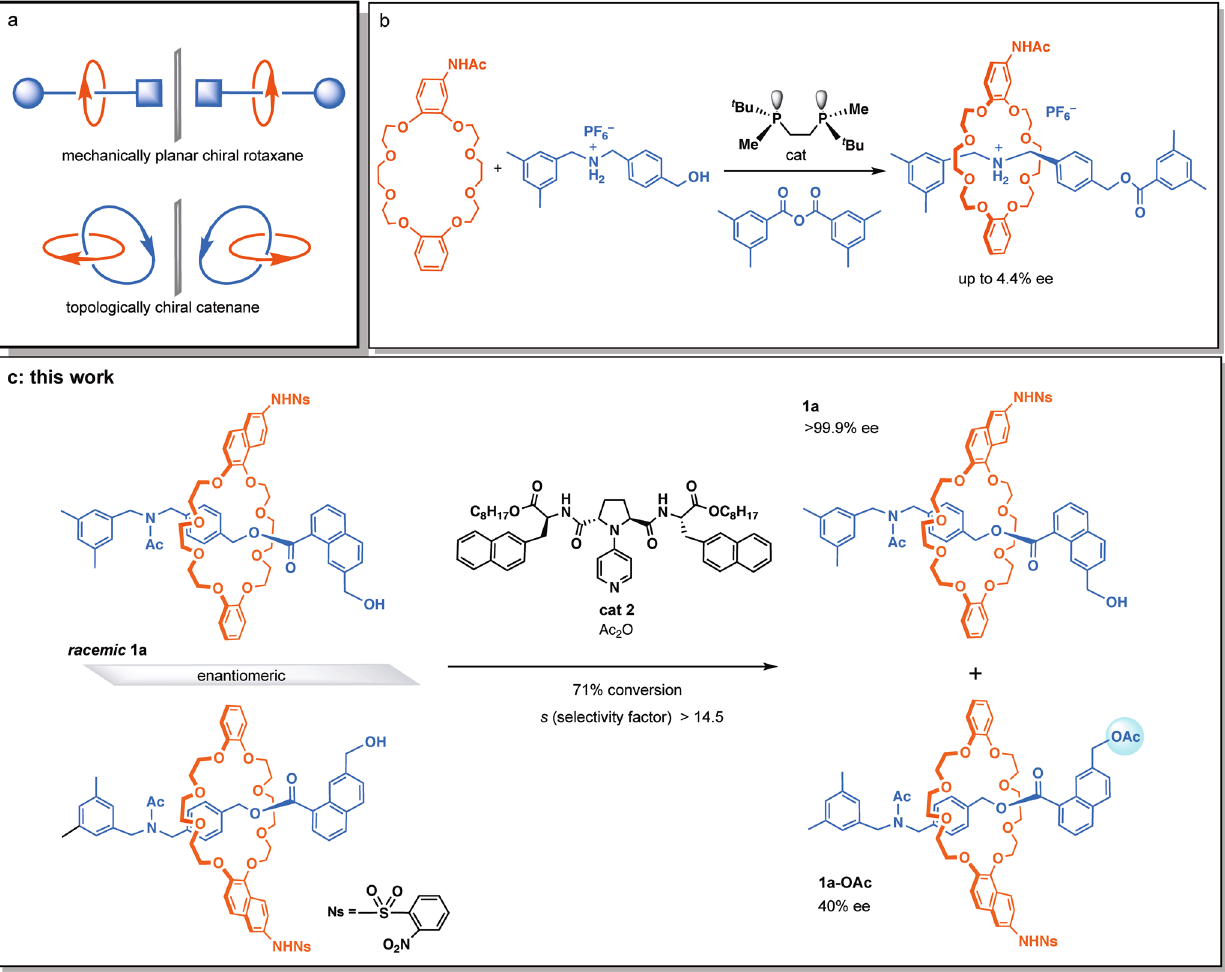
Fig. 1 Chirality in mechanically interlocked molecules and its construction. a A schematic presentation of a mechanically planar chiral rotaxane and a topologically chiral catenane. b Takata ’ s pioneering approach toward catalytic enantioselective synthesis of a mechanically planar chiral rotaxane. c This work: Highly ef fi cient acylative kinetic resolution of racemic mechanically planar chiral rotaxane 1a . The absolute con fi gurations of the acylated product and the recovered rotaxane alcohol were not determined. The ring component and the axis component of rotaxanes are shown in red and blue, respectively, throughout the